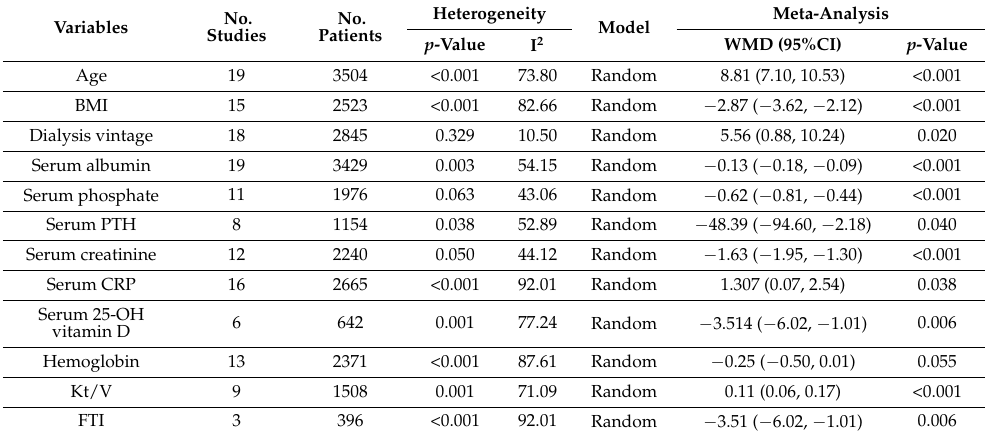
Table 3. Meta-analysis of weighted mean differences in demographic characteristics and laboratory parameters among sarcopenic versus non-sarcopenic dialysis